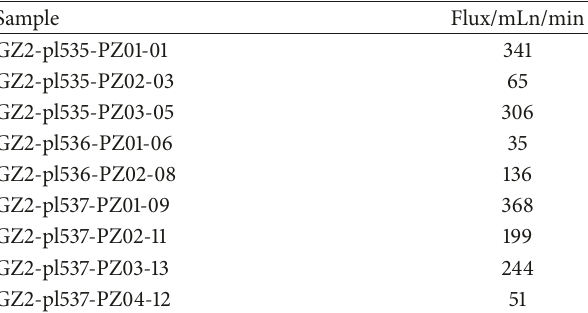
Table 2: Gas fluxes measured from the nine gas streams sampled from the Aquitaine Shelf (normalized to the atmospheric pressure).